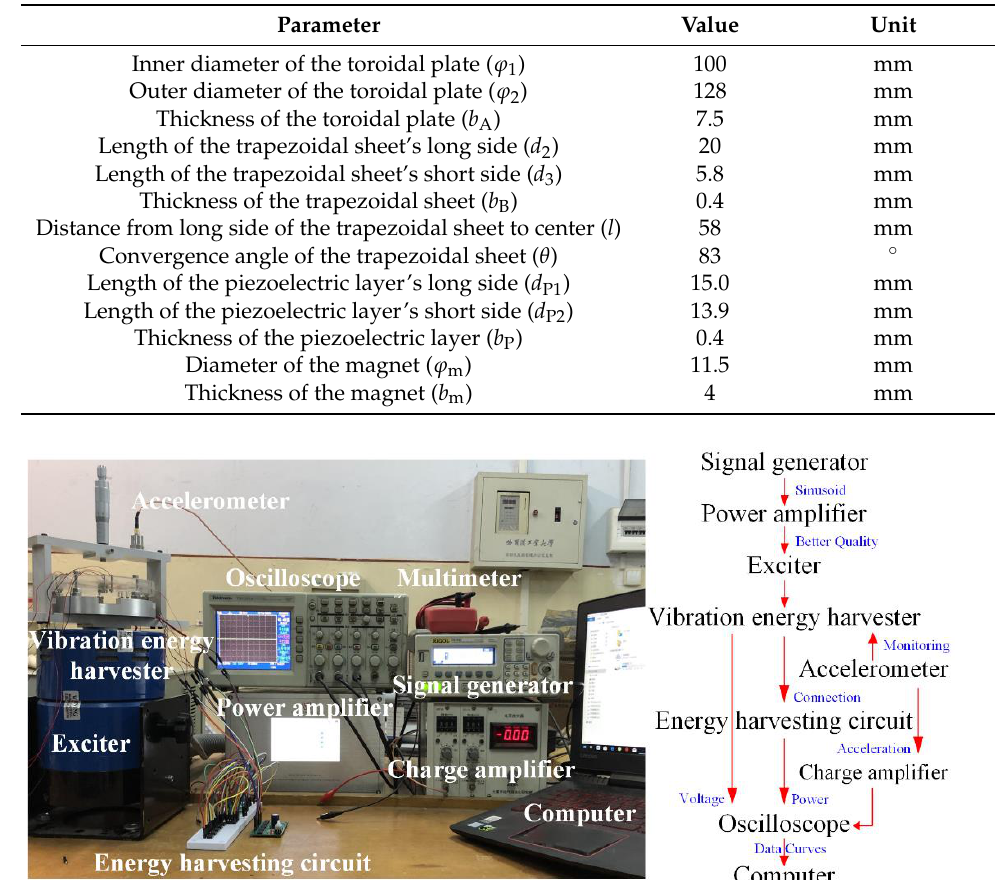
Figure 2. Schematic diagram of experimental test system.